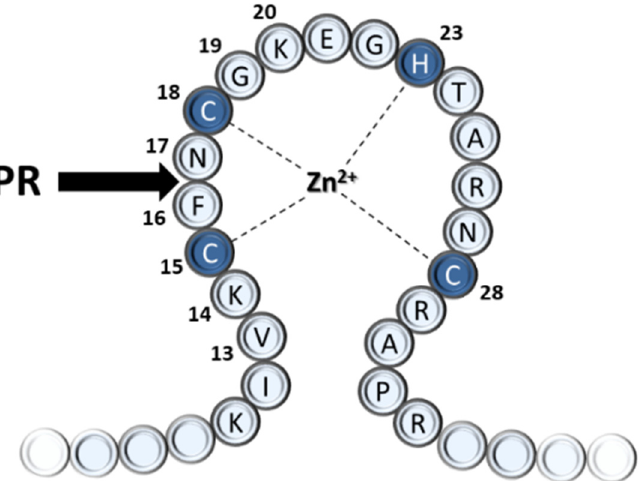
Figure 1. The N-terminal sequence of the first (proximal) zinc-finger of the HIV-1 nucleocapsid protein. The sequence is numbered, the Cys and His residues involved in zinc binding are coloured by dark blue. The black arrow indicates the natural cleavage site of PR.